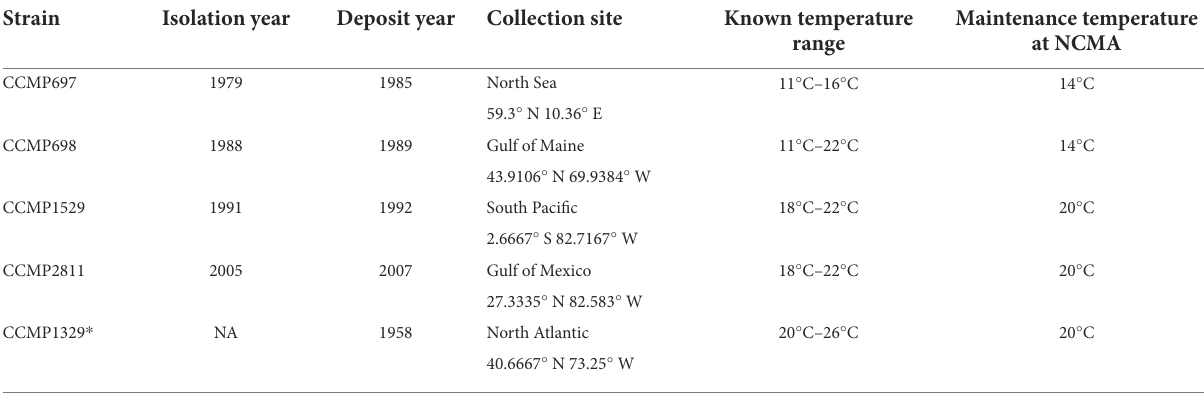
TABLE 1 Isolation and deposit year, collection site, known temperature range, and maintenance temperature at NCMA of Prorocentrum cordatum strains investigated in this study.